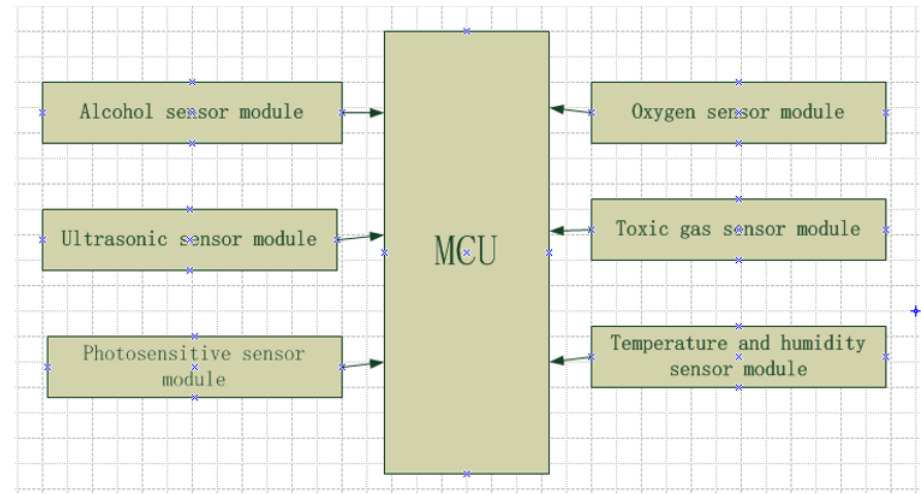
Fig. 1. System function module